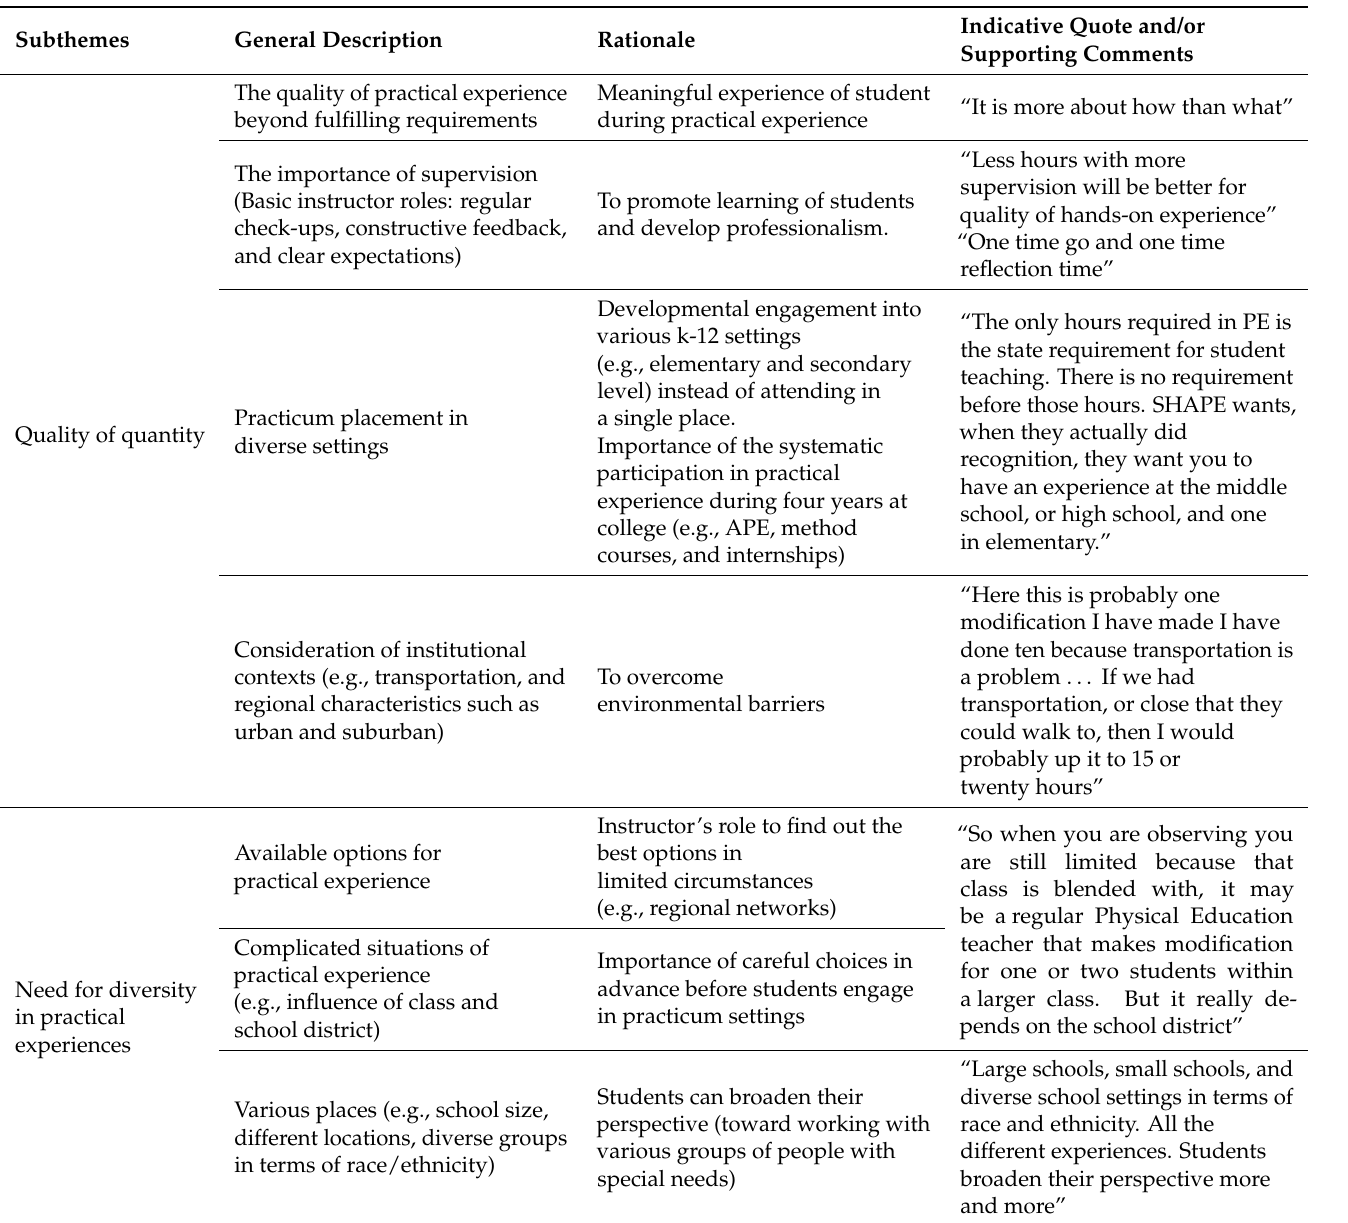
Table 2. The points to be considered and supporting comments for practical experience of